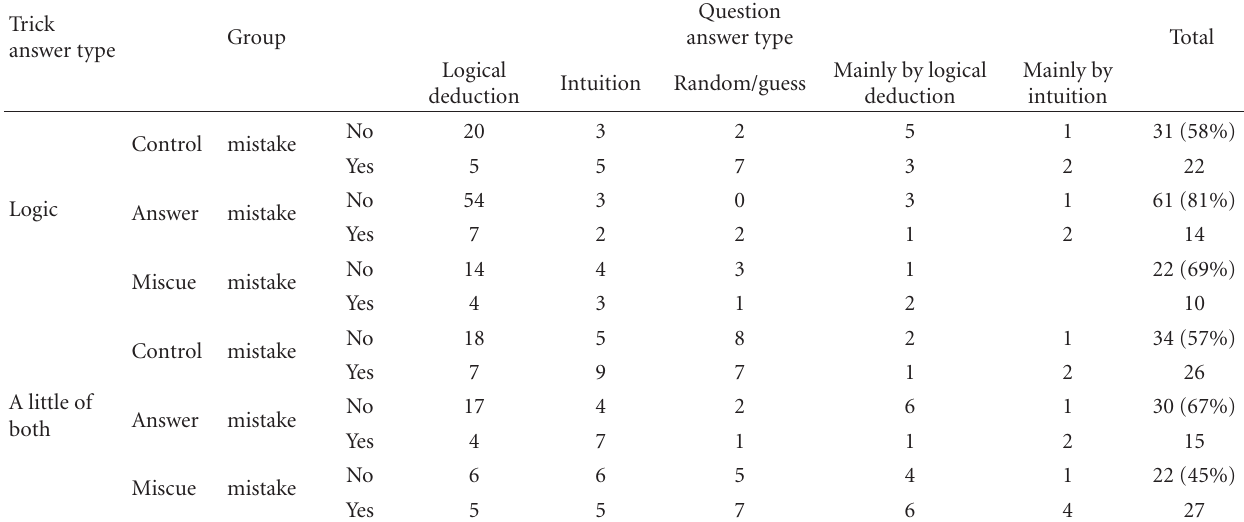
Table 6: Results of the 4 way crosstabluation analysis (mistake ∗ question answer type ∗ group ∗ trick answer type). Trick answer type